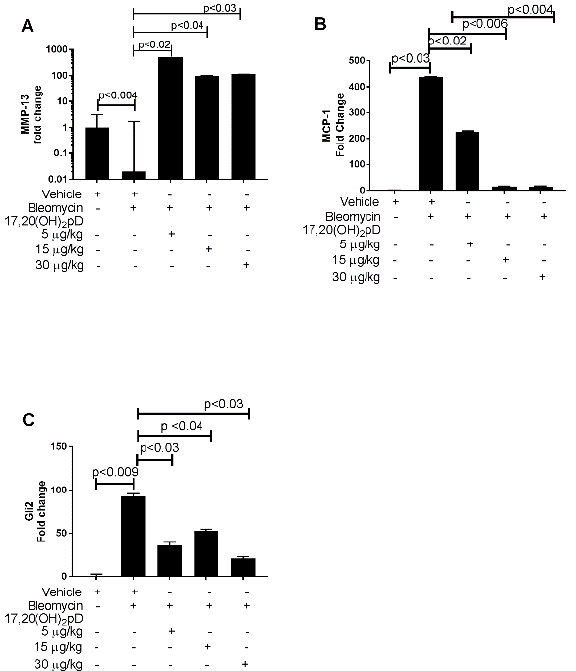
Figure 3. 17,20S(OH) 2 pD modulates the mediators of the TGF- β 1 pathway. C57BL/6 mice (n = 6